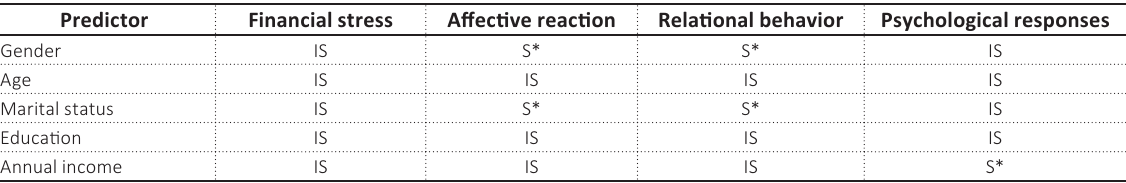
Source: Analysis of survey data.